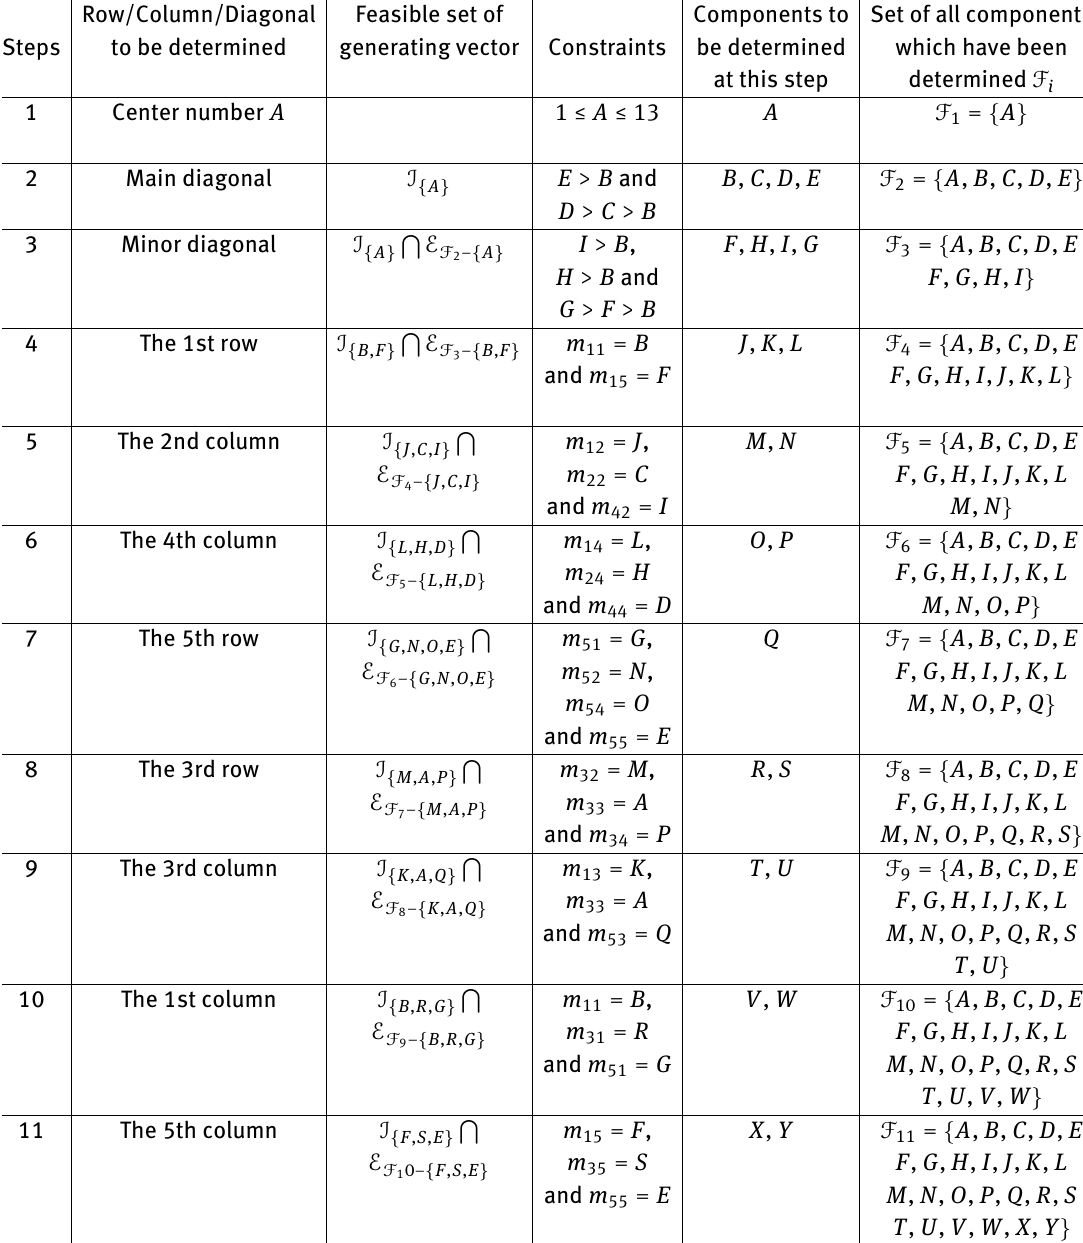
Table 2: Details of enumeration algorithm for generating all basic forms of MS- 5